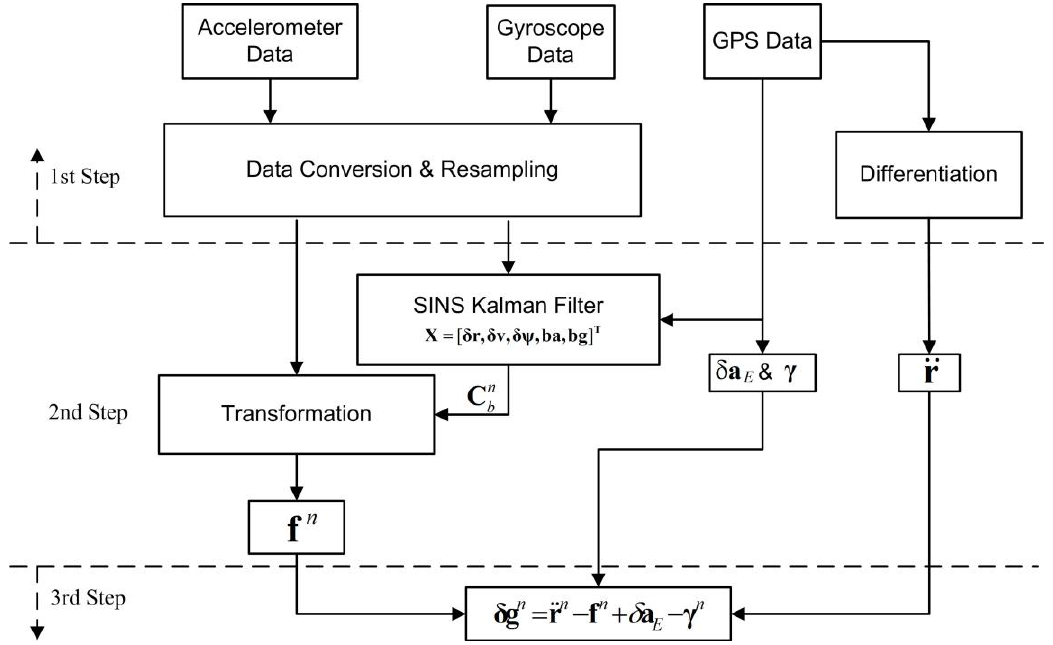
Figure 4. A summary of the process of using the raw measurements made by the sensors to derive the raw gravity disturbance [31]. Waypoint GrafNav software is used to interpret GPS data. The 15 states in Kalman Filter are error of positions, velocities, attitudes, bias of accelerometers and